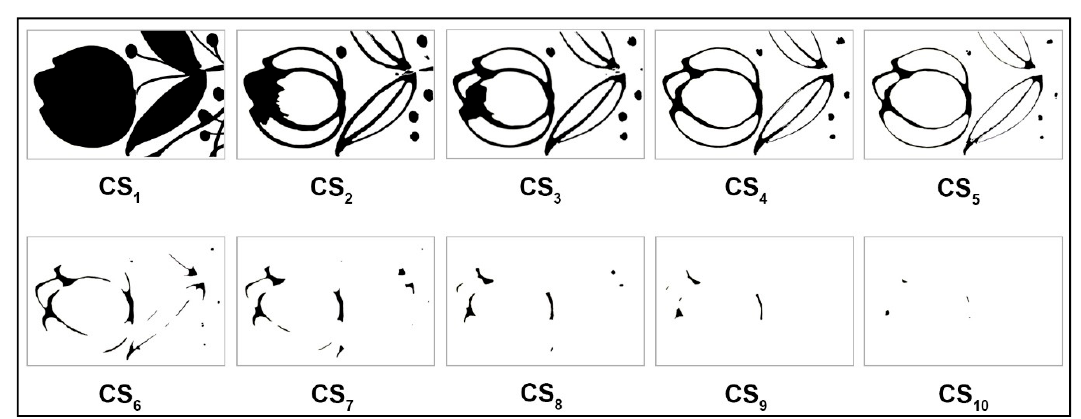
Figure 3. Cross-sections extraction of an oil painting model with blank mode.